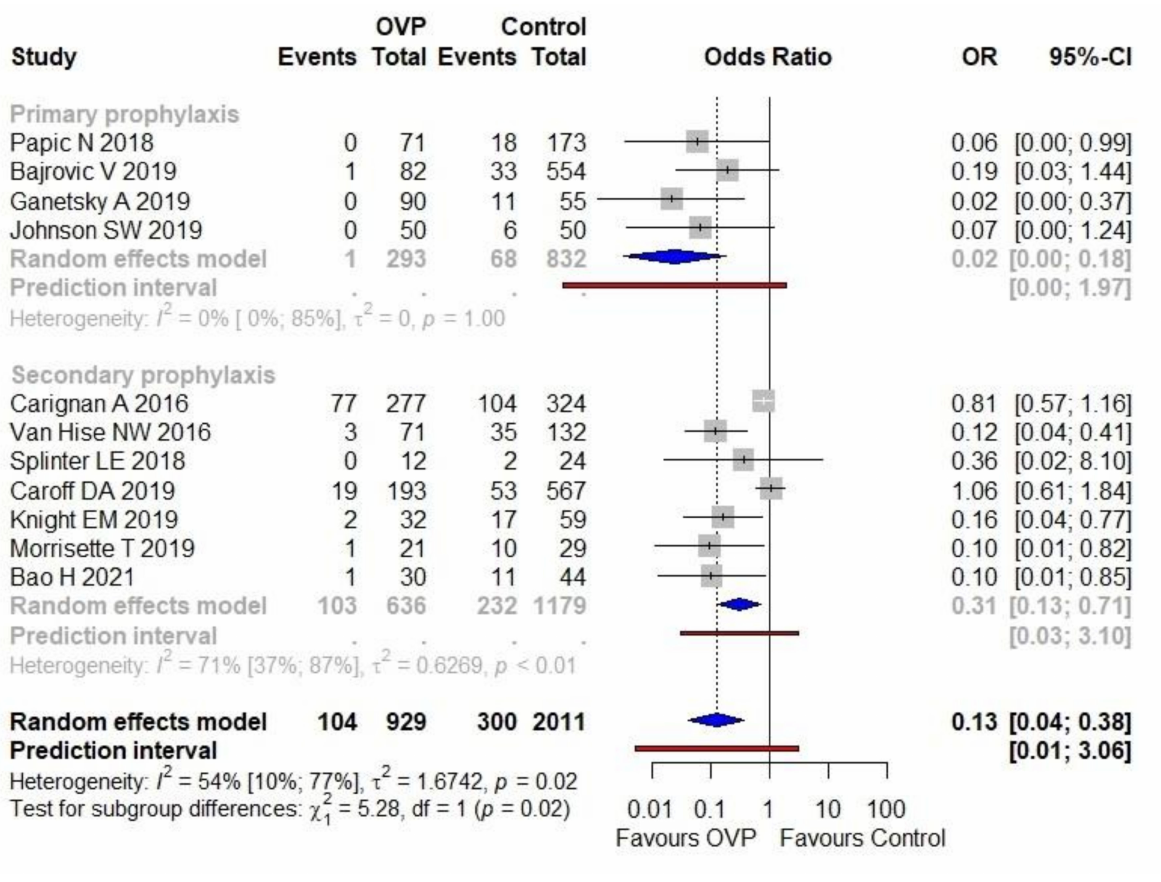
Figure 2. Meta-analysis regarding the association of OVP with CDI prevention, overall and across the principal subgroups. Abbreviations: CDI, Clostridioides difficile infection; OR, odds ratio; OVP: oral vancomycin prophylaxis; 95%-CI, confidence intervals at 95%. Vertical line indicates ‘no difference’ point between the two options. Squares represent odds ratios. Diamonds represent pooled odds ratios for all studies. Horizontal lines represent 95%